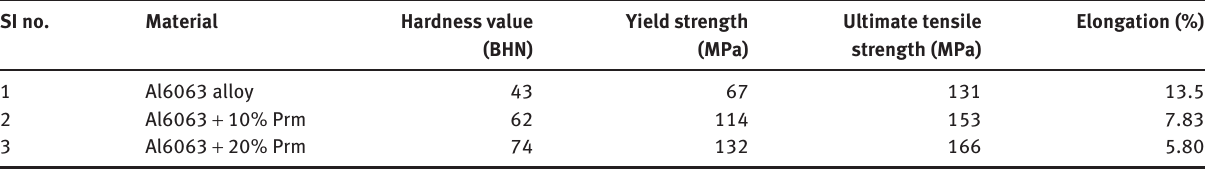
Table 2: Mechanical properties of the prepared composites and Al6063 alloy (T1 temper condition). SI no.